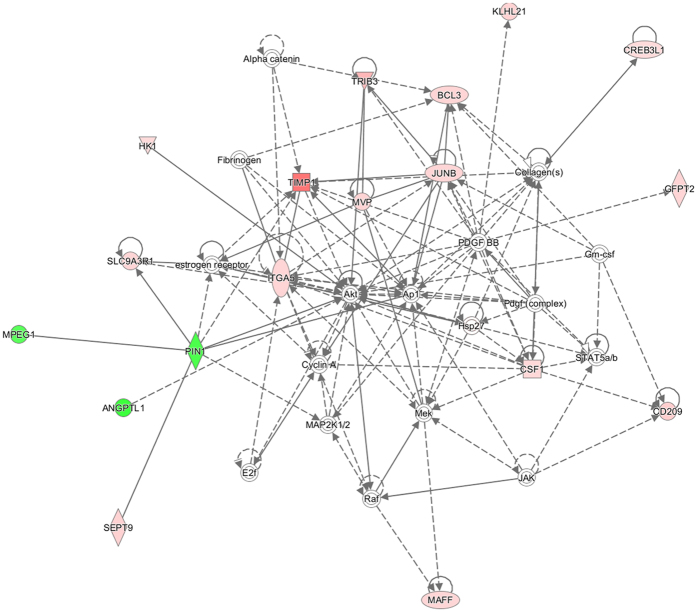
The top-scoring regulatory network identified with the IPA software corresponded to Cardiovascular Disease, Cardiovascular System Development and Function, Organismal Injury and Abnormalities.Genes that are upregulated and downregulated in HIGH pigs (when compared with the LOW ones) are displayed within red and green nodes, respectively. Solid and dashed lines between genes represent known direct and indirect gene interactions, respectively. The shapes of the nodes reflect the functional class of each gene product: transcriptional regulator (horizontal ellipse), transmembrane receptor (vertical ellipse), enzyme (vertical rhombus), cytokine/growth factor (square), kinase (inverted triangle) and complex/group/other (circle).